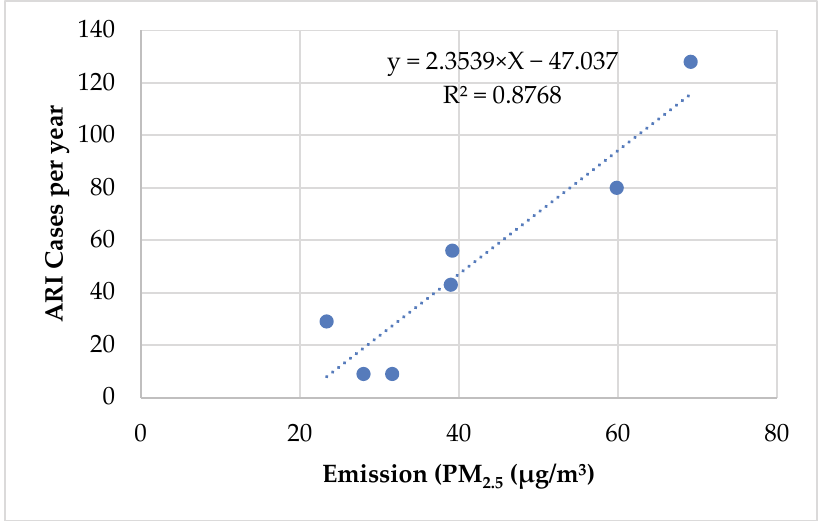
Figure 12. Cases ARI vs. Emission PM 2.5.